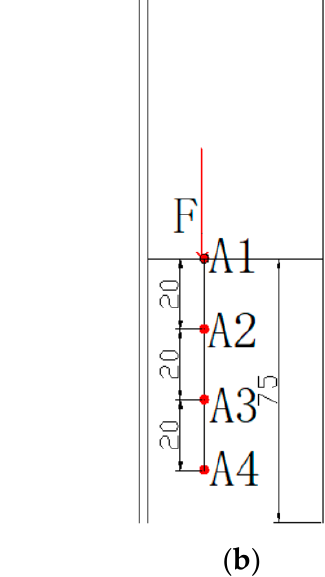
Figure 7. The layout of the acceleration sensor in the tunnel (cm): ( a ) annular layout; ( b ) axial layout on the tunnel invert.